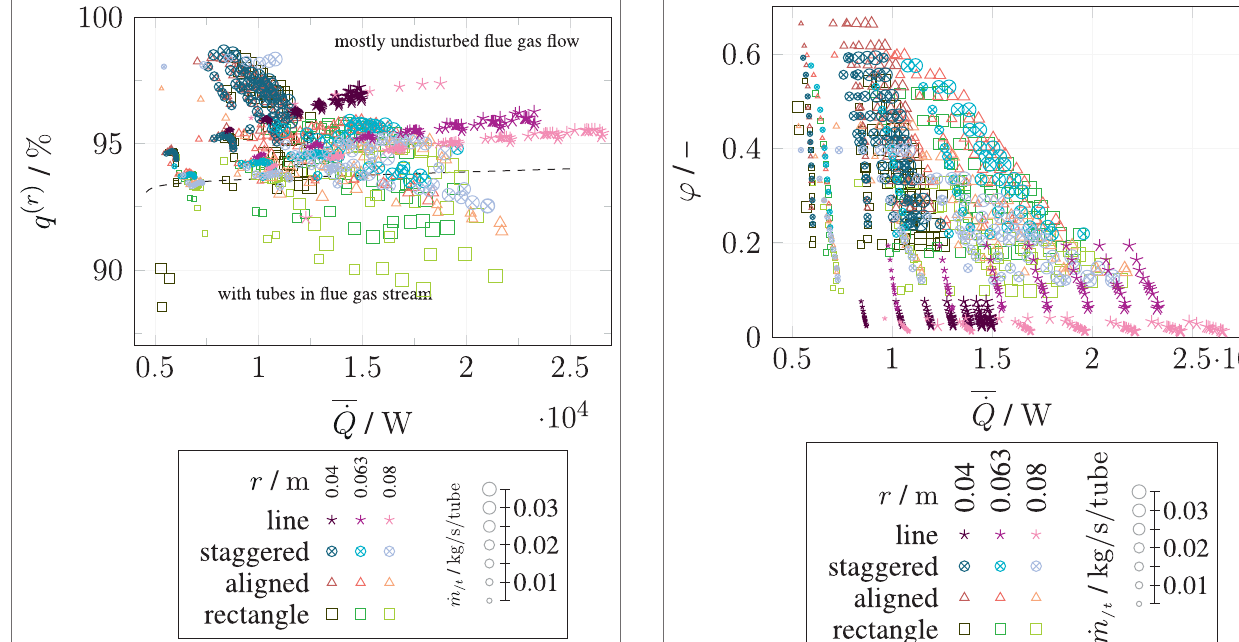
FIGURE9| Averageviewfactor φ vs.meanheat fl ux _ Q .Thesymbol(and its color family) indicates the con fi guration of the data point. Shades of the respective color indicate the inner tube radius r . Symbol size indicates the mass fl ow rate _ m / t of fl ue gas per reforming tube.